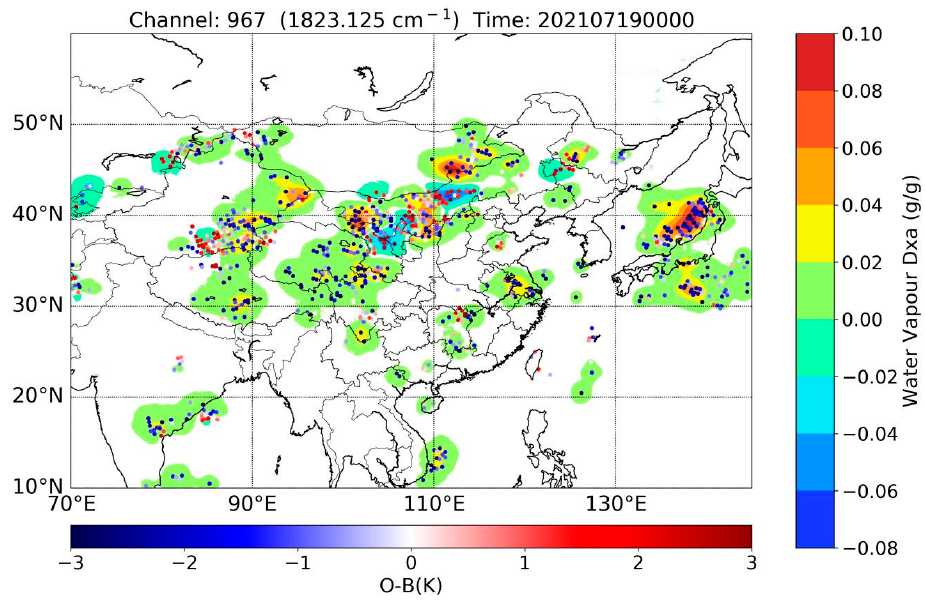
Figure 4. Specific humidity increments (g g − 1 ) between the CTRL and GIIRS single channel 967 (1823.125 cm − 1 ) assimilation experiment at 400 hPa, at 0000 UTC on 19 July 2021. Colored dots rep ‐ resent the O − B (K) after bias correction and quality control of channel 967.